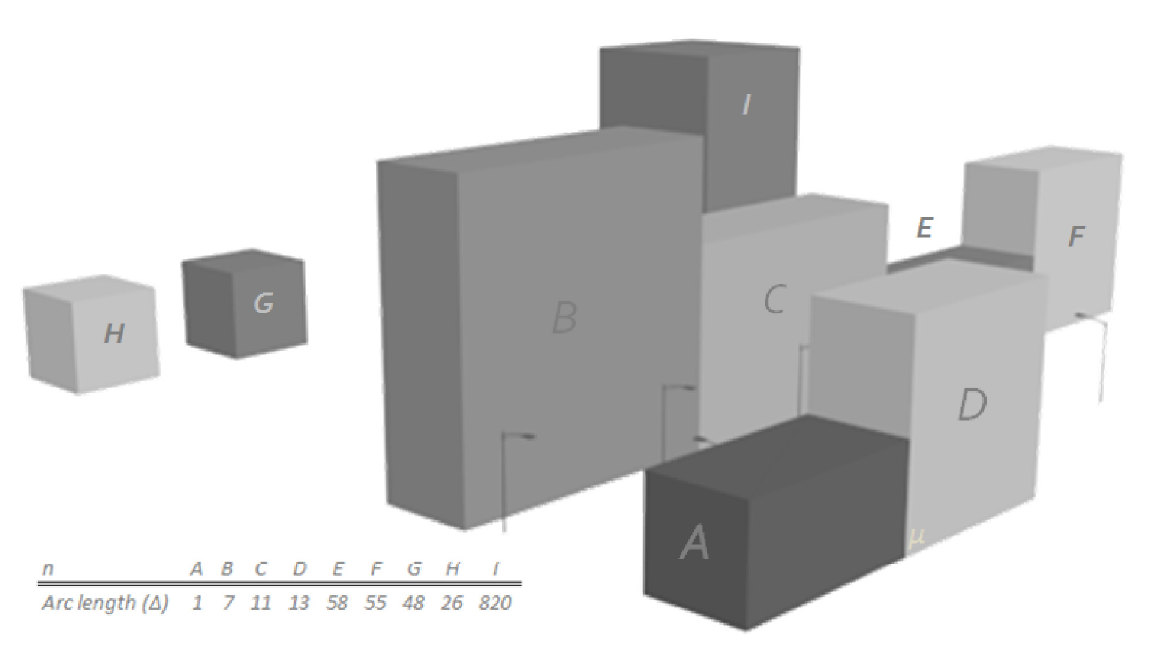
Figure 12: The nearest arc lengths ( Δ ) from building A are B, C and D